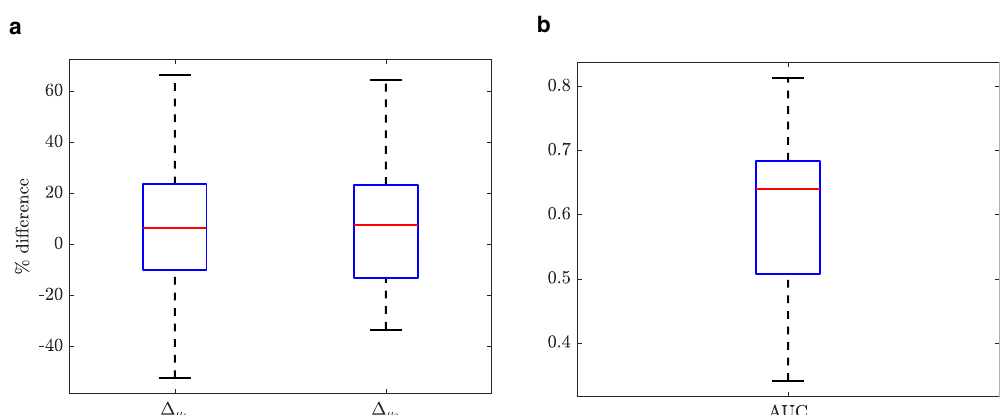
Fig. 4 The boxplots comparing the gait speed distribution between the clinic and home for all the patients. ( a ) The percentage of the difference between clinic and home for preferred gait speeds μ 1 and μ 2 , ( b ) the area under the ROC curve (AUC) of CDF clinic versus CDF home : Center line: median; box limits: upper and lower quartiles; whiskers: 1.5 × interquartile range.